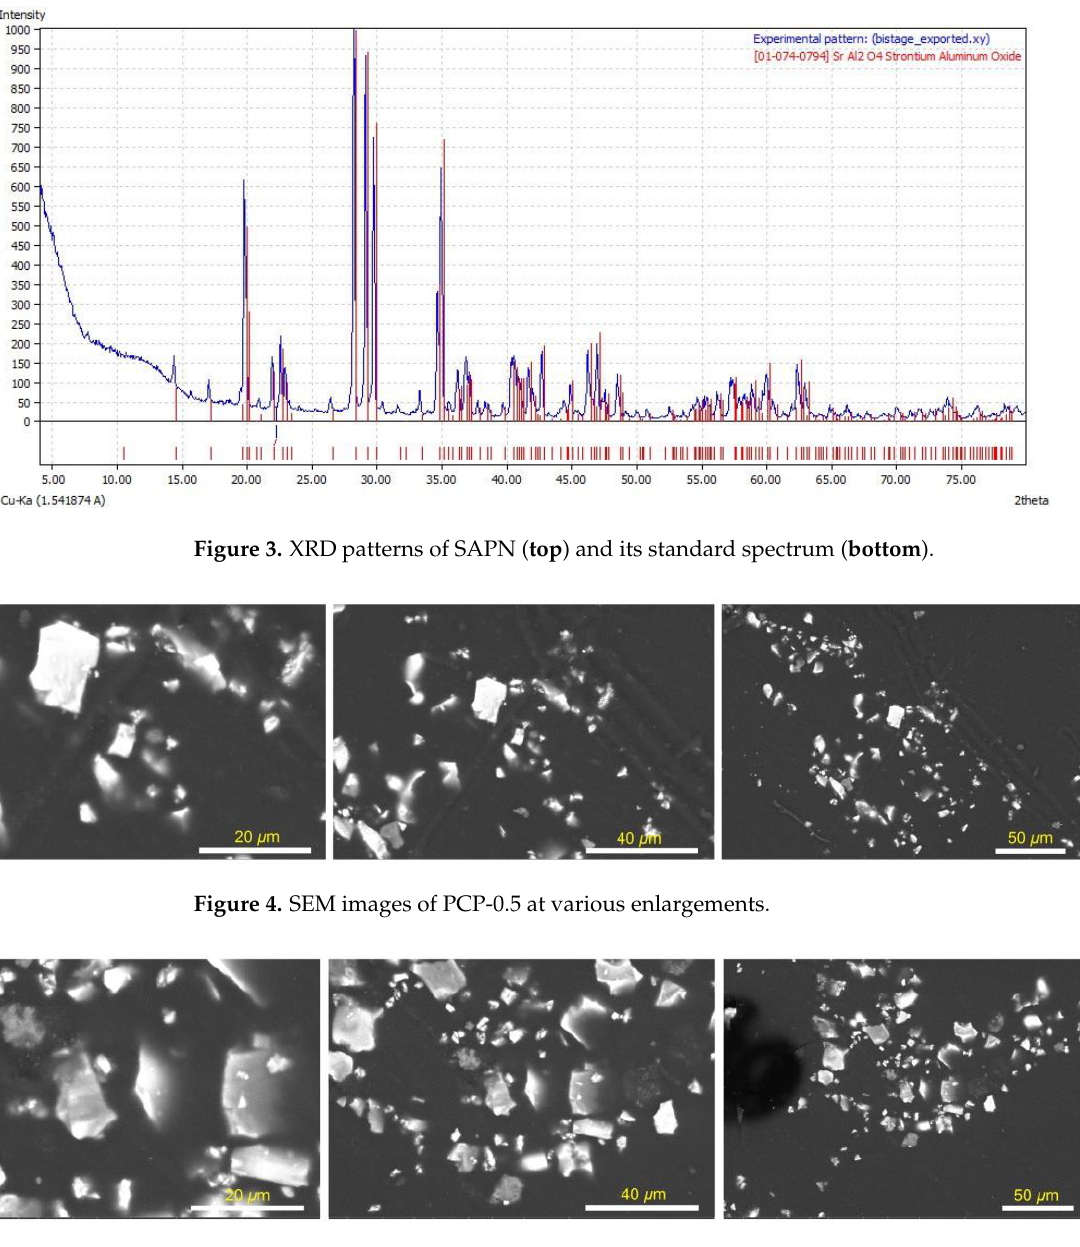
Figure 4. SEM images of PCP-0.5 at various enlargements. Figure 6. EDX spectra of PCP-4. Table 1. Elements (wt%) monitored by EDX of SAPN@PCP at three separate points (P 1 , P 2 and P 3 ). SAPN@PCP